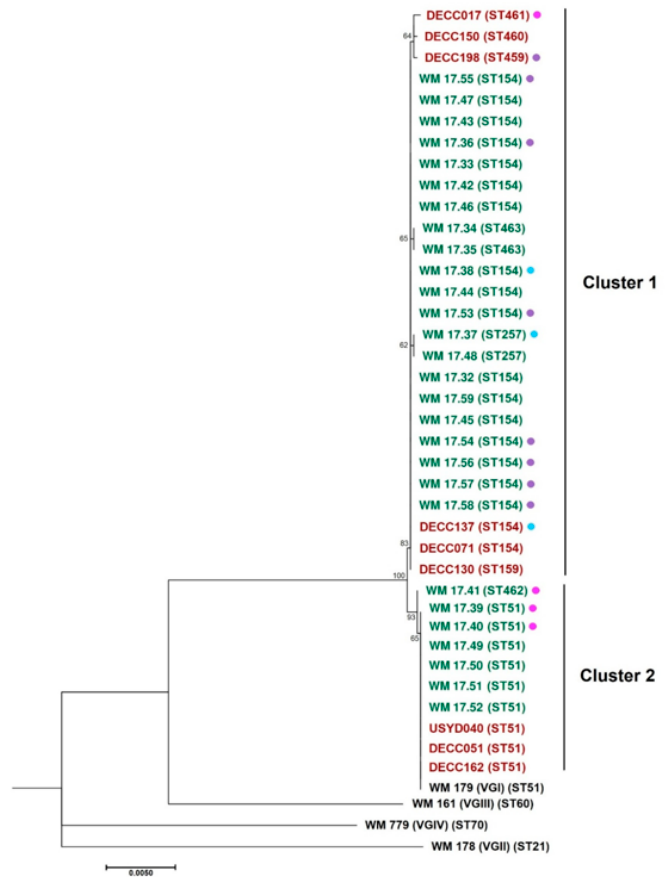
Figure 1. Dendrogram obtained using the concatenated sequences for all seven loci of the consensus C. gattii / C. neoformans MLST scheme for all of the isolates genotyped herein. The isolates highlighted in green are environmental, and the isolates highlighted in red are from koalas. The STs for the C. gattii standard reference strains are included in black. Environmental isolates obtained from a transect within the home range of a koala with a sequence typed isolate are matched using coloured circles. Bootstrap values based on 1000 replicates are shown at each node. The scale bar represents the number of substitutions per site along the branch lengths.